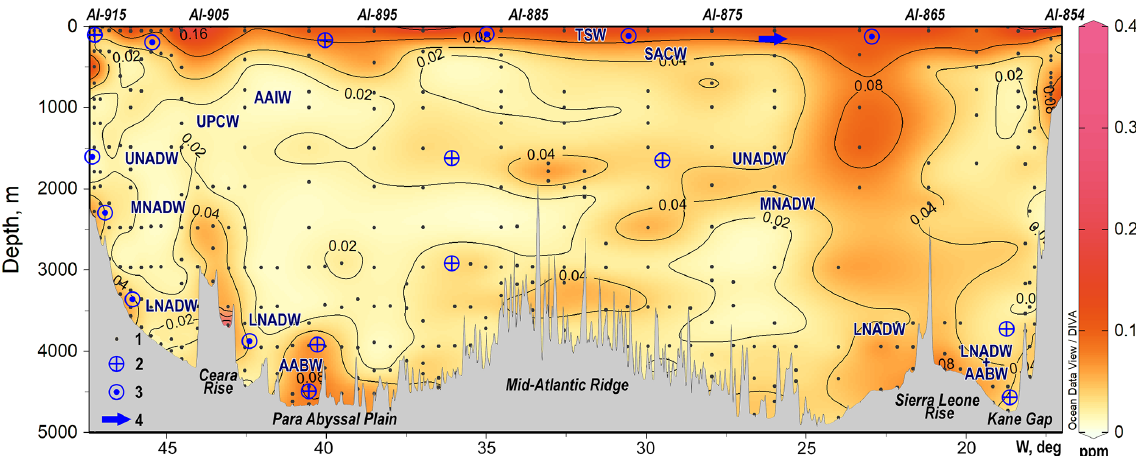
Figure 4. Distribution of the SPM volume concentration ( ppm ) on the Ioffe-2000 transect, done with Ocean Data View (Schlitzer, 2018). Numbers indicated on the bottom left: 1 denotes sampling points, 2 denotes northward current, 3 denotes southward current, 4 denotes eastward current. Isolines are in geometric progression, for water mass abbreviations see text. Bottom topography similar to Sokov et al. (2002). The interpolation was done via the DIVA gridding (Barth et al., 2010) with 25‰ X -scale length and 65‰ Y -scale length.